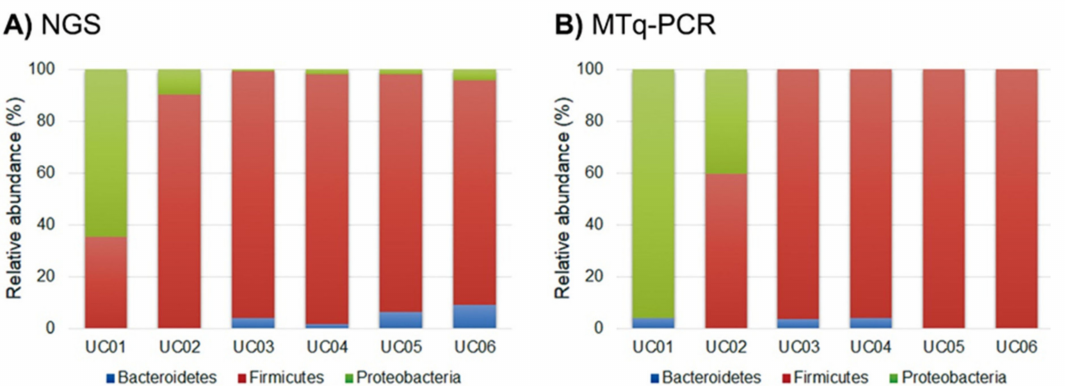
Figure 4. Relative proportions of the three phyla from fecal samples of UC patients determined by ( A ) NGS and ( B )